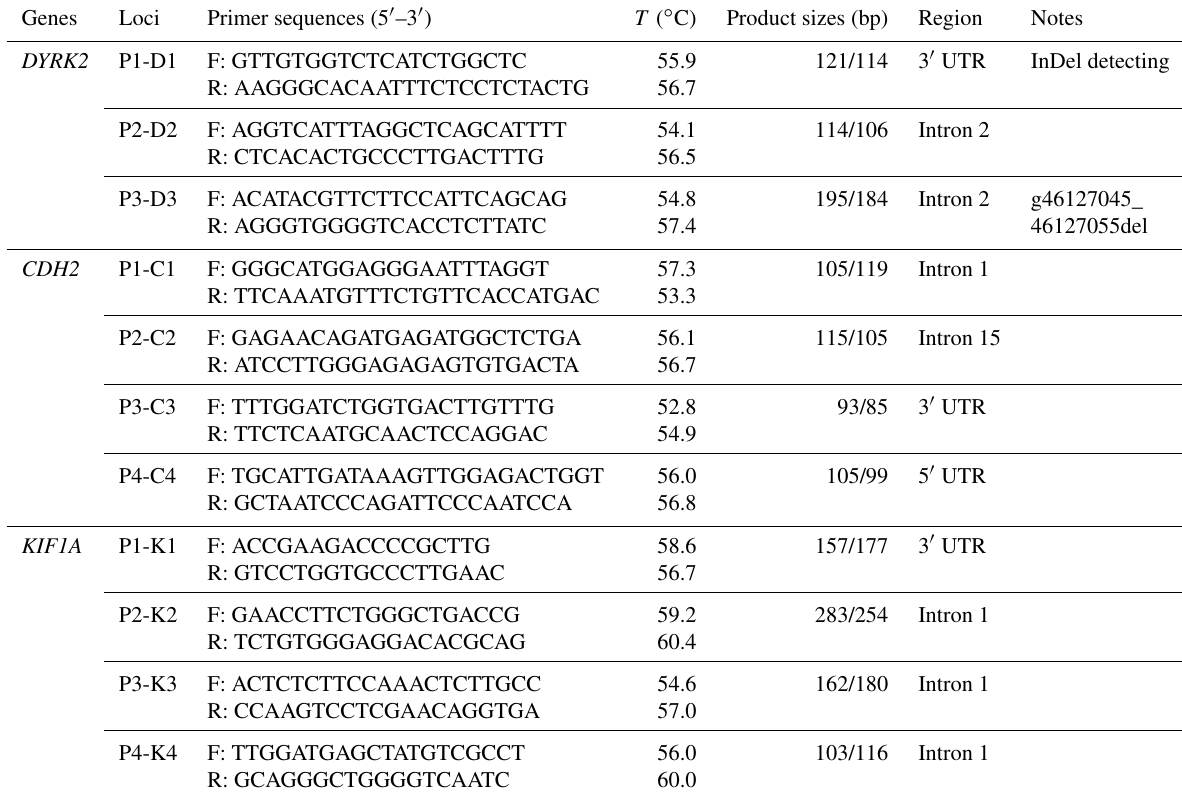
Table 1. PCR primer sequences of three genes for amplification. Genes Loci Primer sequences (5 (cid:48) –3 (cid:48) ) T ( ◦ C) Product sizes (bp)